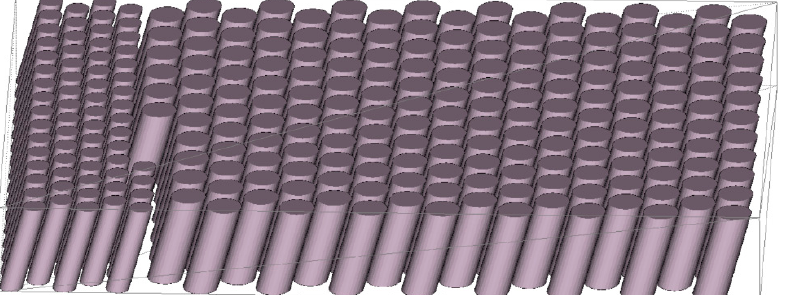
Figure 20. Arrangement of the CGx on BP_1_2-5.